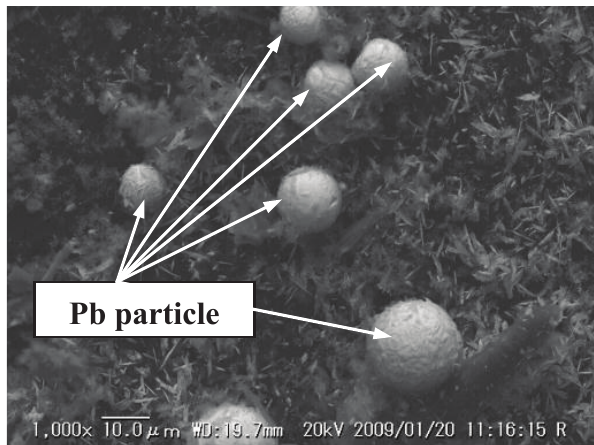
Figure 12. Observed Pb particles on the membrane filter.